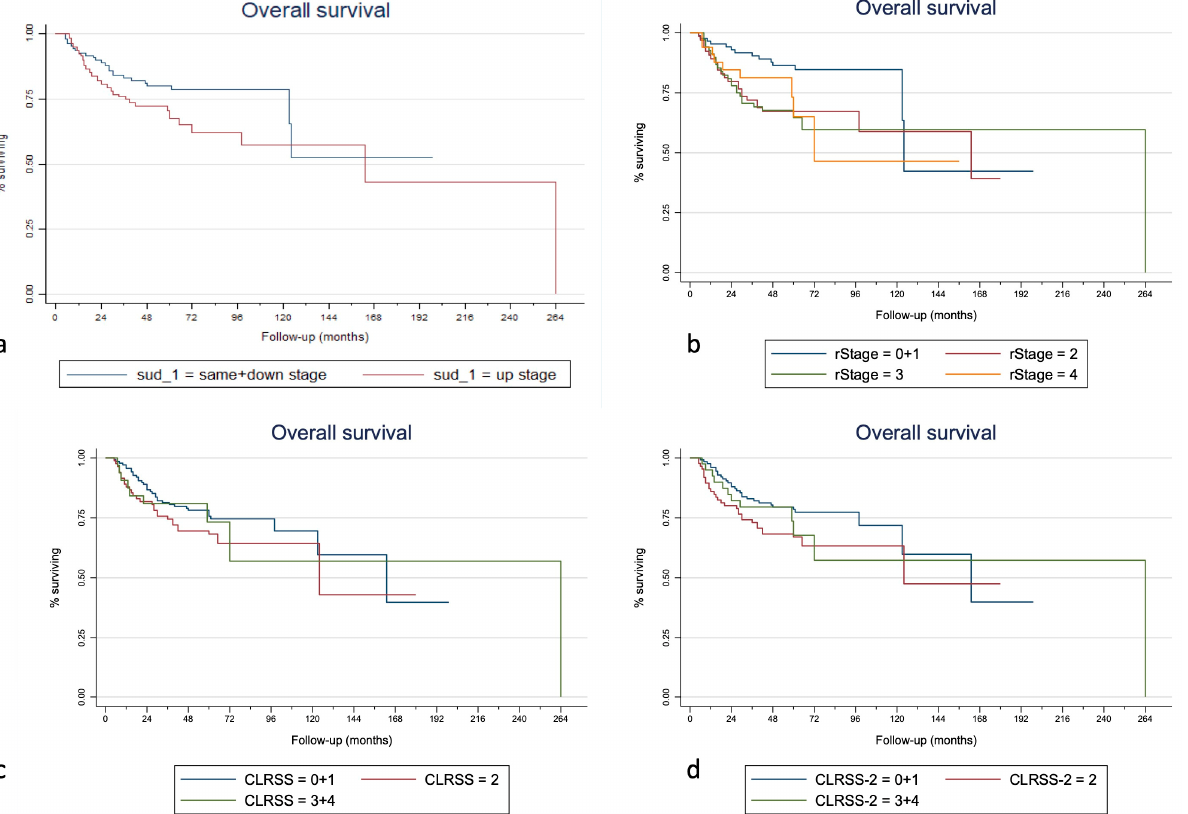
Figure 1. Kaplan–Meier curves for overall survival stratified for the SUD ( a ), rTNM ( b ), CLRSS ( c ), and CLRSS-2 ( d ) staging classes (merged as the analyses were performed).